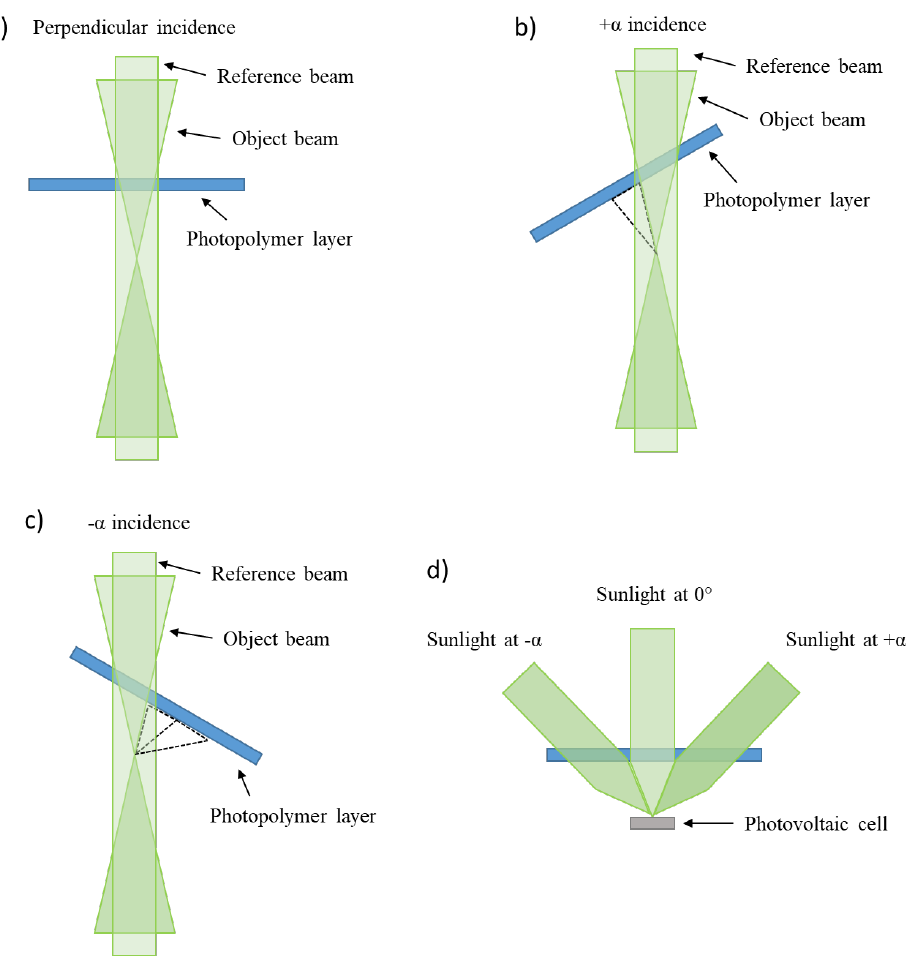
Figure 11. Recording approach for three partially overlapped holographic lenses. Writing lens for a perpendicular ( a ), +α ( b ) and −α ( c ) incidence; ( d ) passive tracking collection of the sunlight.